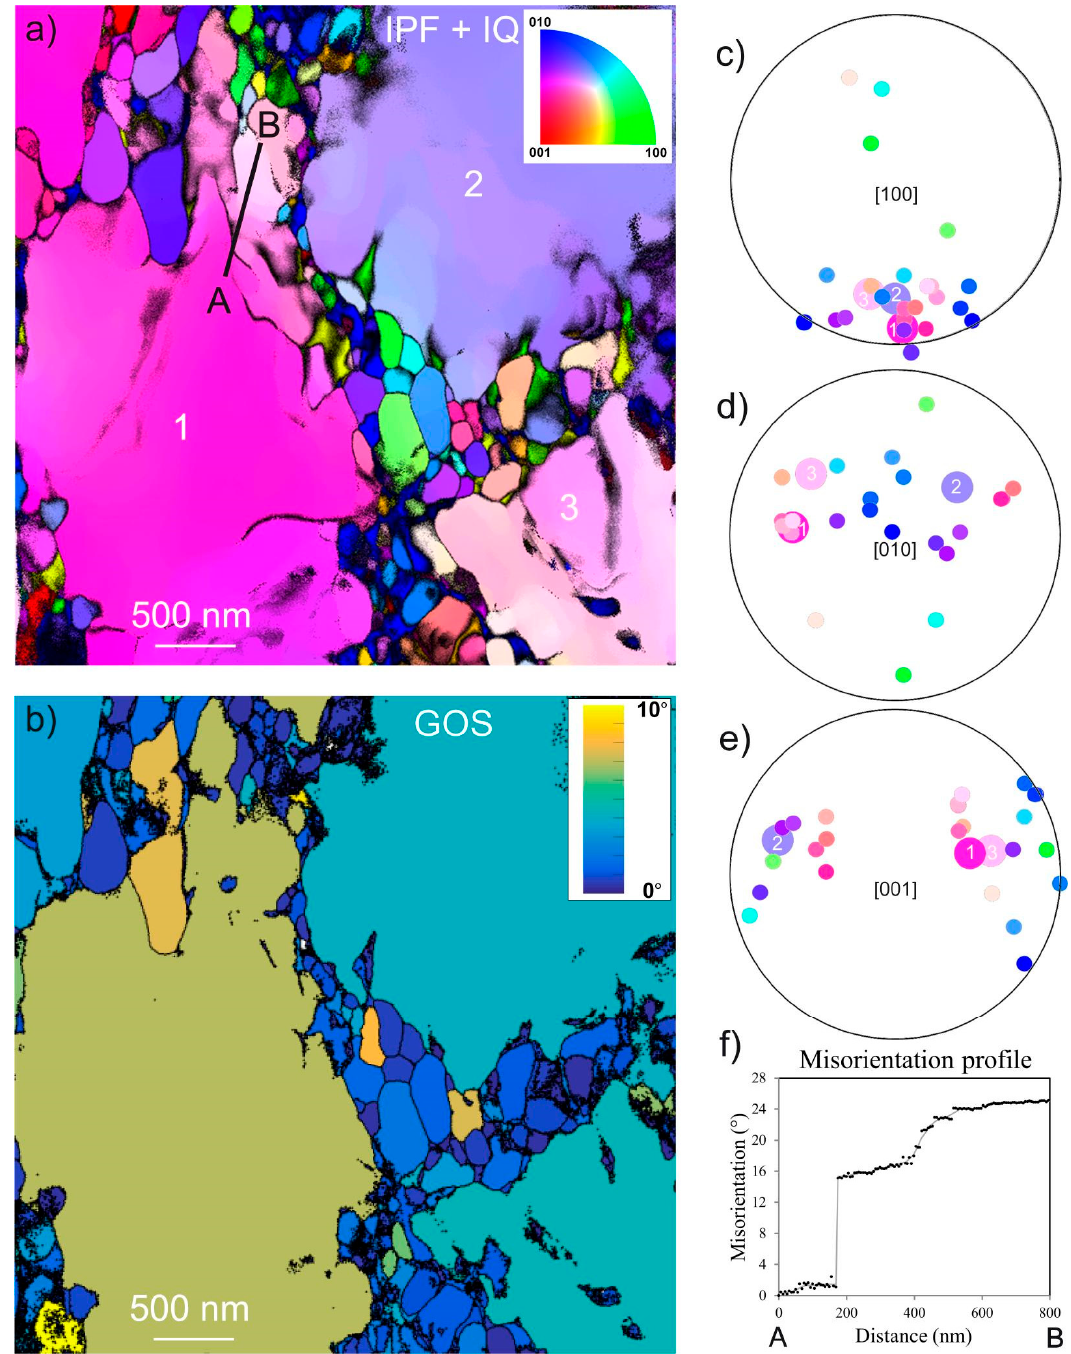
Figure 10. For70B small grains. ( a ) IPF corresponding to the direction perpendicular to the plane of view superimposed with the IQ (Equation (1)); color code inserted ( Pnma ). ( b ) GOS map corresponding to ( a ). ( c – e ) Orientations of the recrystallized grains (color coded as in ( a )) compared to those of the parent grains (labeled 1, 2, and 3 as in ( a )). ( f ) Misorientation profile along the segment A–B displayed in ( a ).